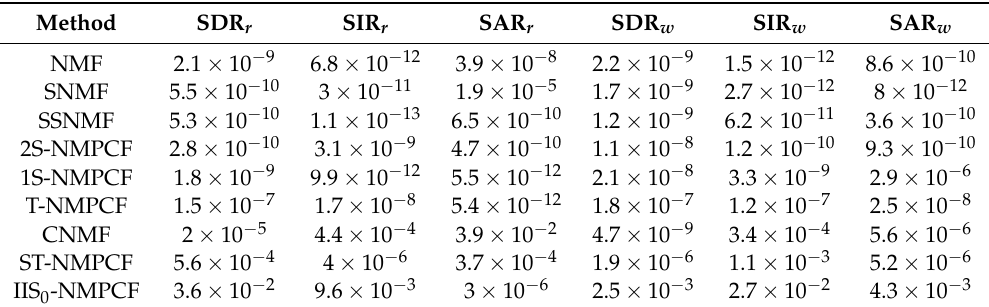
Table 6. Analysis of the statistical significance of the respiratory/wheezing SDR, SIR and SAR results comparing the proposed method (IIS-NMPCF) with the other evaluated methods using an one-sided paired t -test in the databases T1L (see Figure